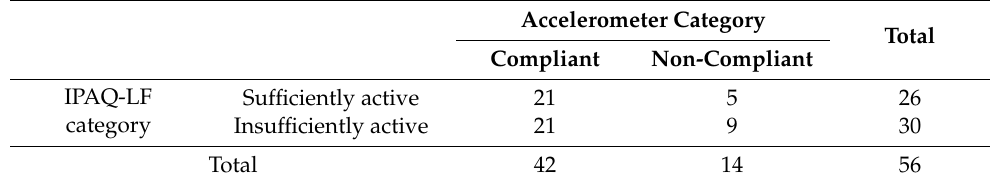
Table 5. Distribution of participants according to their physical activity level categorized by the IPAQ-LF and by